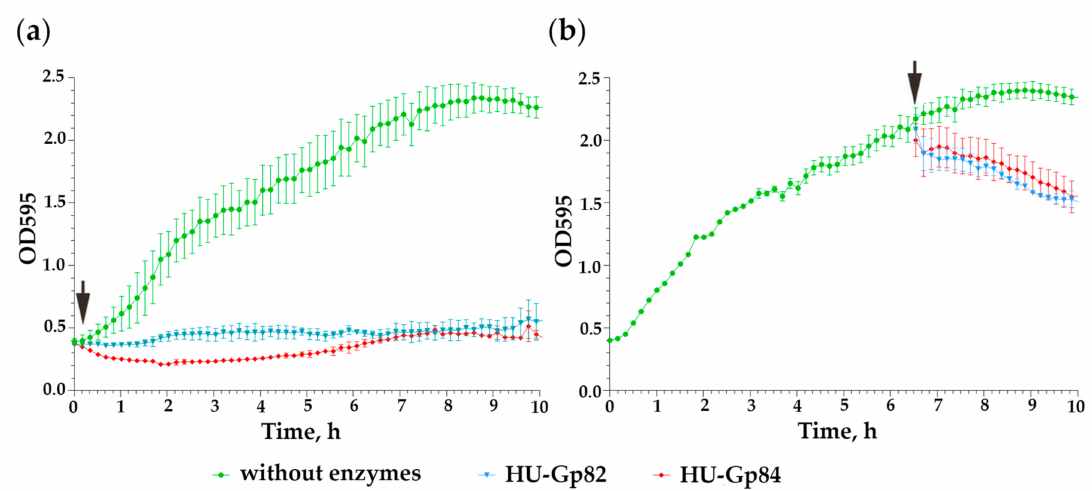
Figure 9. Effect of HU-Gp82 and HU-Gp84 endolysins on the growth kinetics of E. faecium FS86. Enzymes were added to the cell suspension in the early exponential ( a ) and stationary ( b ) phases of growth. An uninfected culture of E. faecium FS86 was used as a control. The black arrows indicate the addition of endolysins. The graphs were created using GraphPad Prism 8.4.3. Error bars represent the standard deviation of the means from three independent